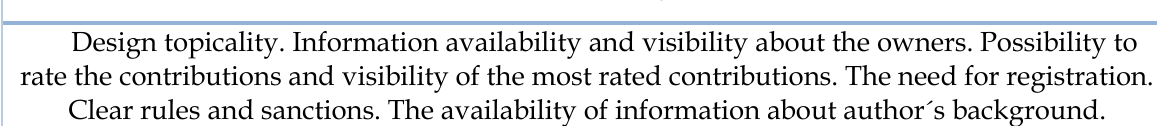
Table 1: Indicators for heuristic evaluation of the interface of online groups